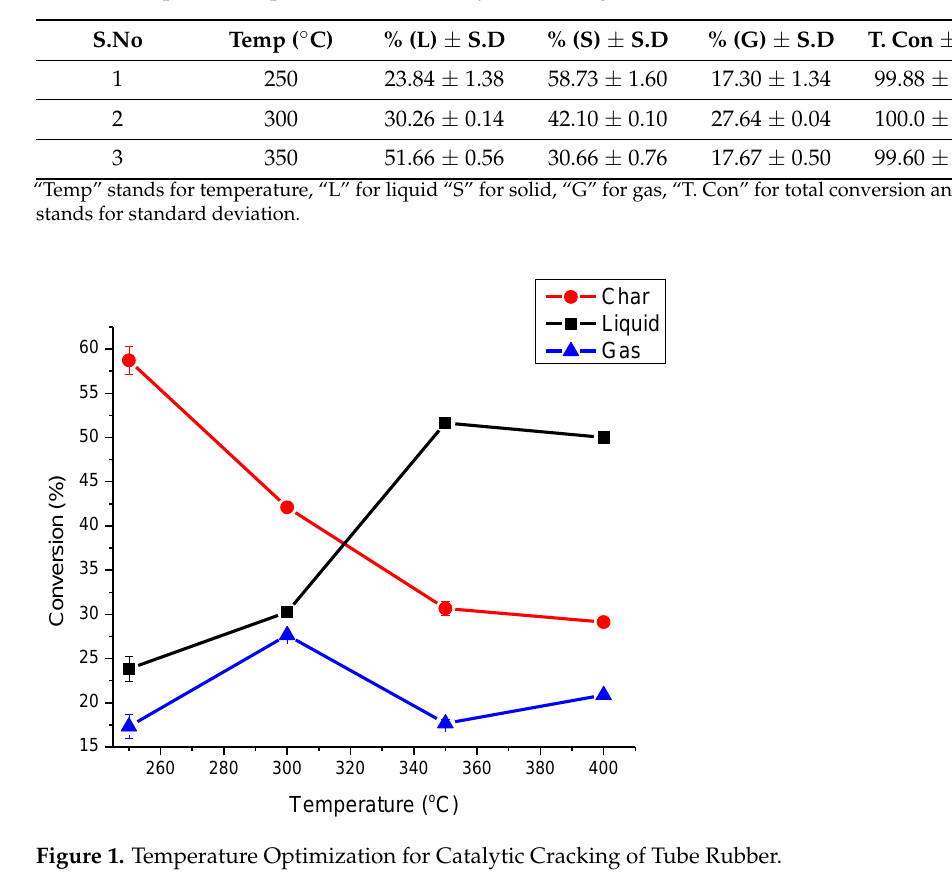
Table 1. Temperature Optimization for Catalytic Cracking of Tube Rubber.